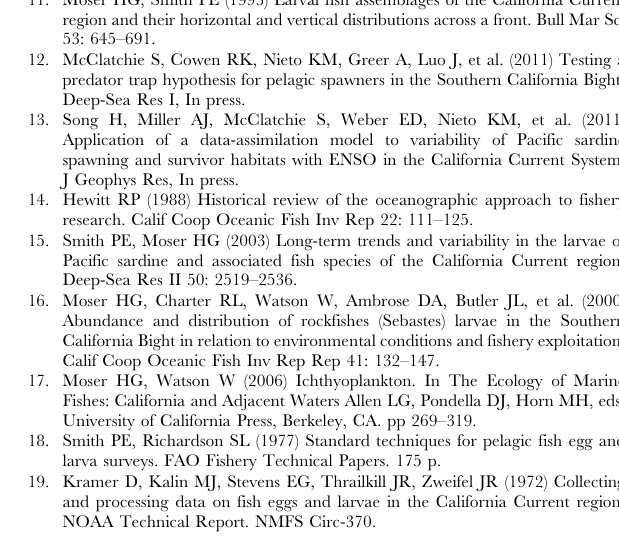
Figure S1 Hellinger-transformed values of oceanic species in the CCA from 2002–2004. (A–C) Nanobrachium ritteri; (D–F) Protomyctophum crockeri ; (G–I) Symbolophorous californien- sis . The white border depicts the boundary of the CCA in this and all Supplemental Figures. The order in which taxa are presented is based on their habitat affinities as defined by [31]. The size of a circle is proportional to its value which ranges between 0 and 1. Figure S2 Hellinger-transformed values of two oceanic and one coastal-oceanic species in the CCA from 2002–